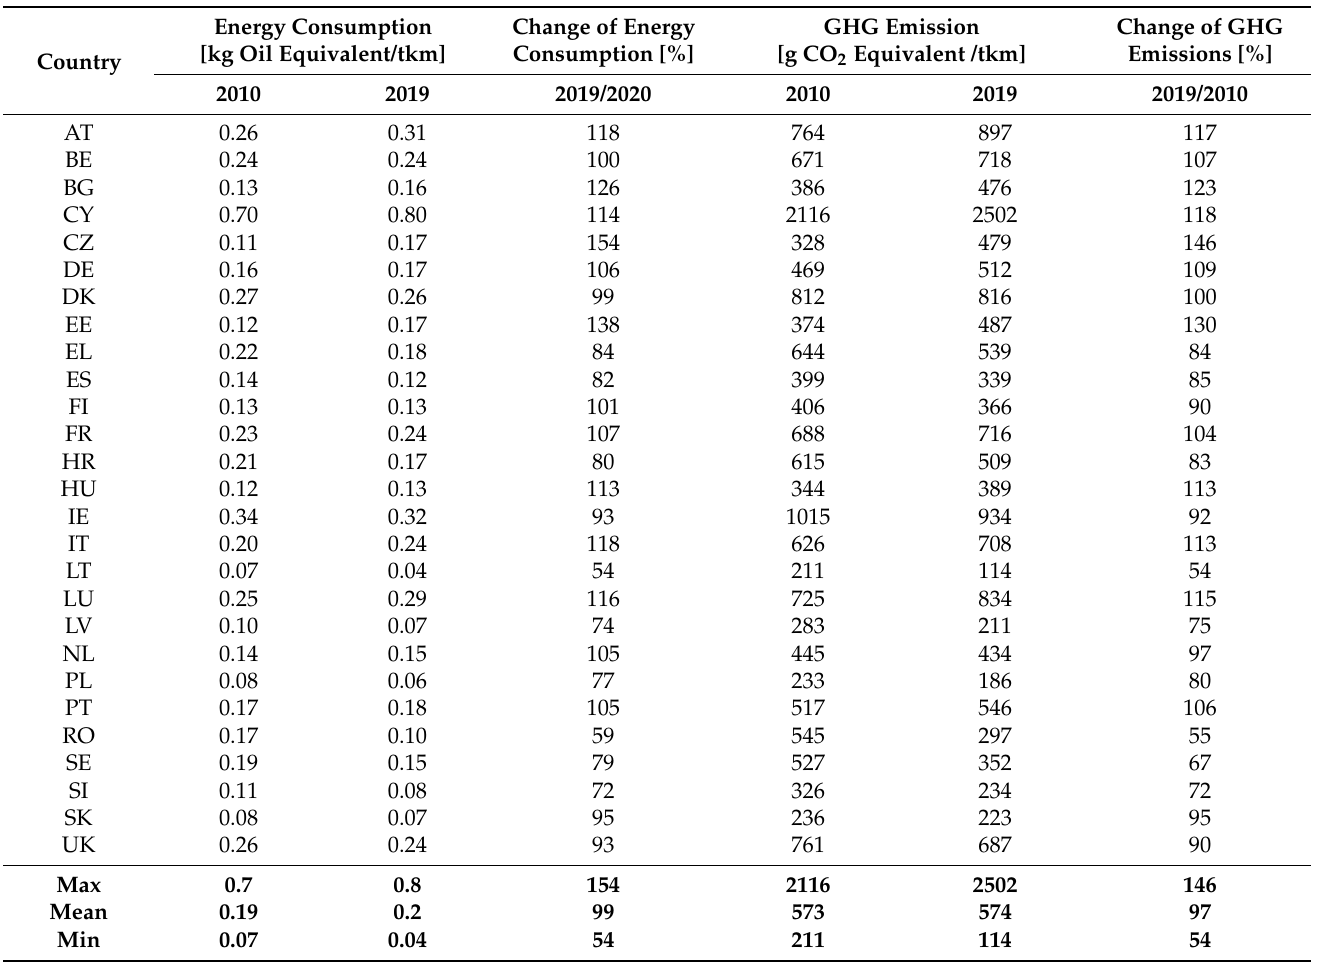
Table 1. Efficiency of energy consumption and efficiency of greenhouse gas emissions from road freight transport in the EU in the years